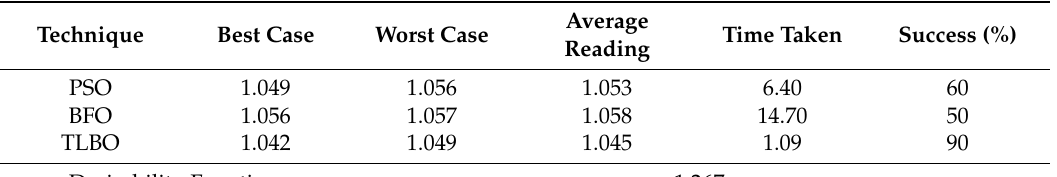
Table 7. Comparison of combined objective values by PSO, BFO, teaching learning-based optimization (TLBO), and desirability function approach.